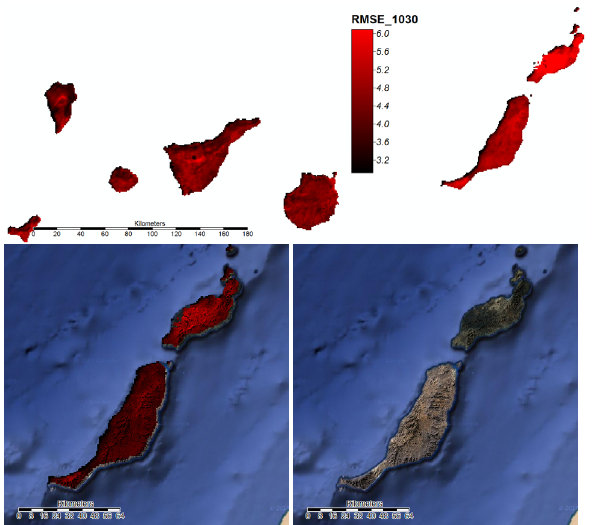
Figure 7. Root mean squared error (RMSE) in K at 10:30 = inter-diurnal and inter-annual variability of LST; Subset for arid islands; Base map (Google Earth, both with analytical hillshading)